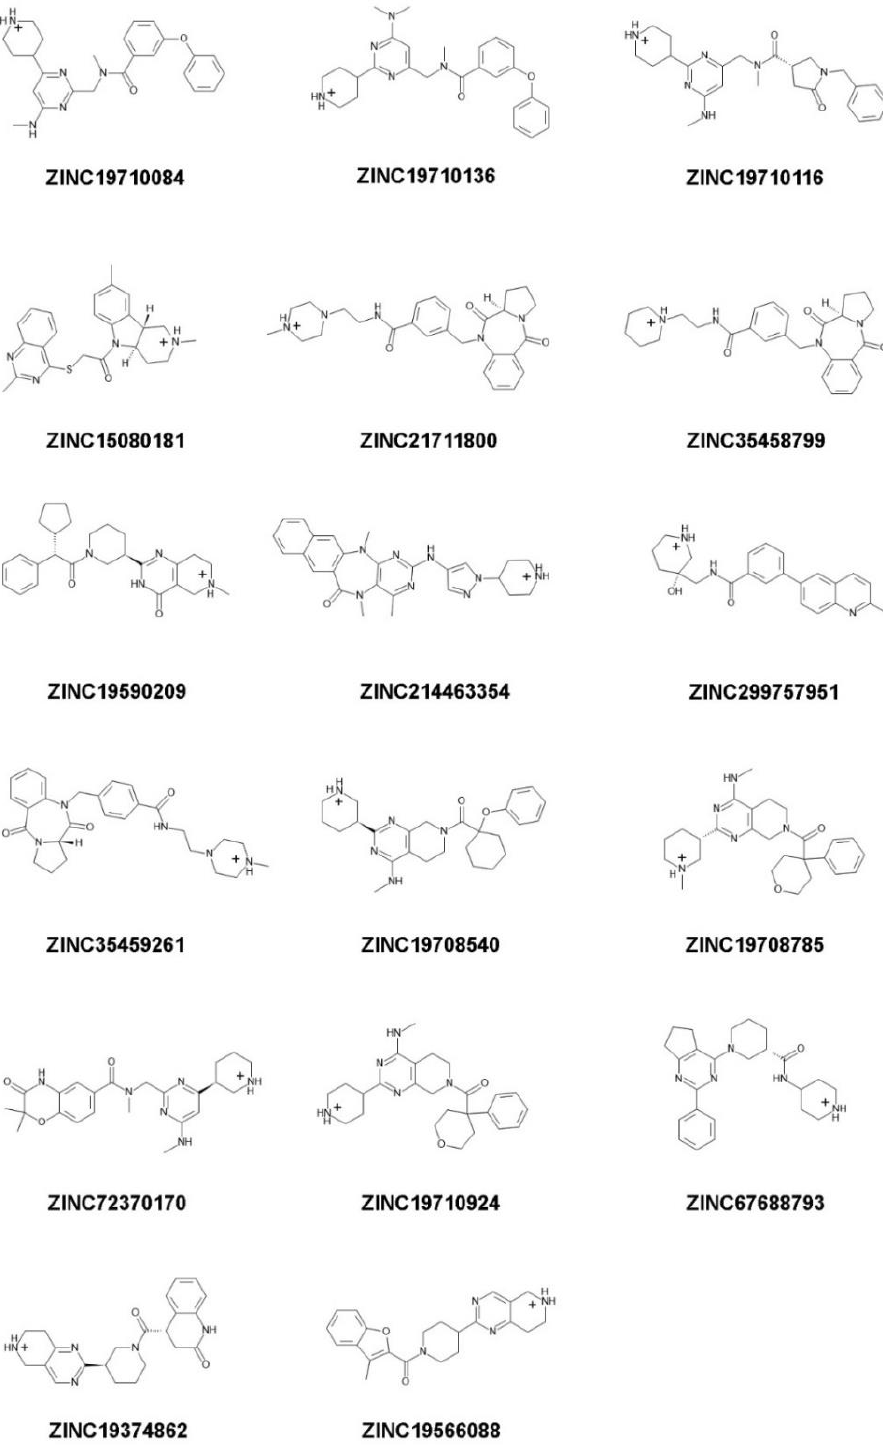
Figure 6. Structure, protonation, and charge at pH 7.4 of ligands identified in the virtual screening with predicted salt bridge with the C-terminus of NMT. The salt bridge is formed between the positively charged moiety of the small molecule and the negatively charged C-terminal carboxyl group of NMT protein. The positive charge of the ligand is located at a distal piperidine or piperazine ring.